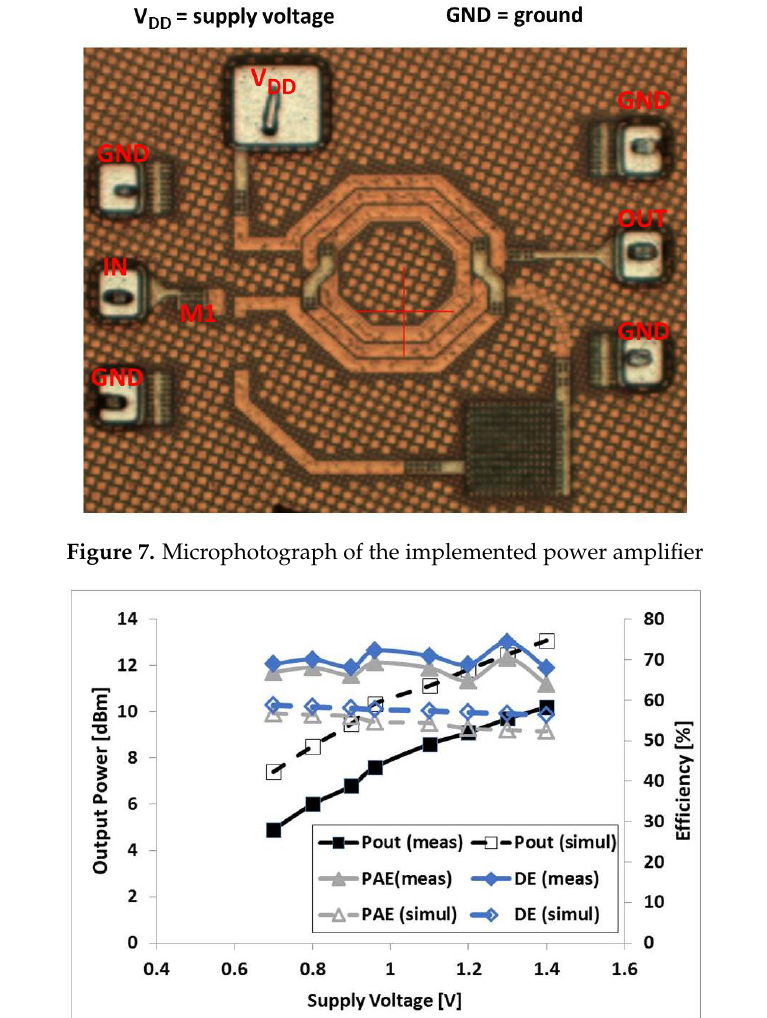
Figure 8. Transformer-based class-E PA: Output power, drain efficiency and power-added efficiency versus the DC supply voltage (measurement: solid black, blue and grey; simulation: dashed white, blue and